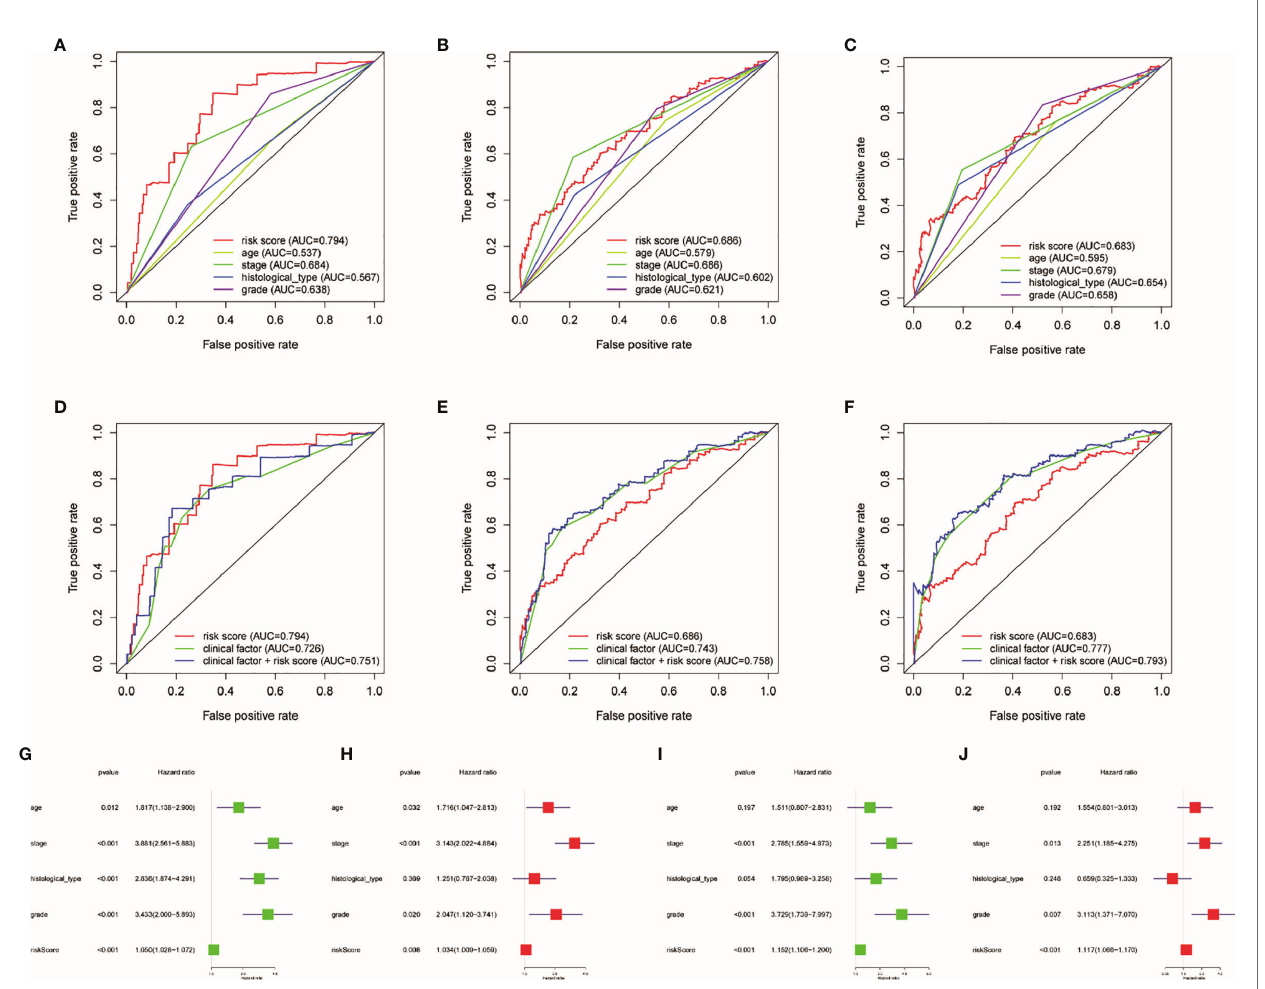
FIGURE 6 | In fl uence of clinical factors and risk score on prognosis. Clinical factor and risk score AUC of 1- (A, D) , 3- (B, E) , and 5-year (C, F) survival rates. Uni- and multivariate Cox regression analyses in the entire (G, H) and train sets (I, J)